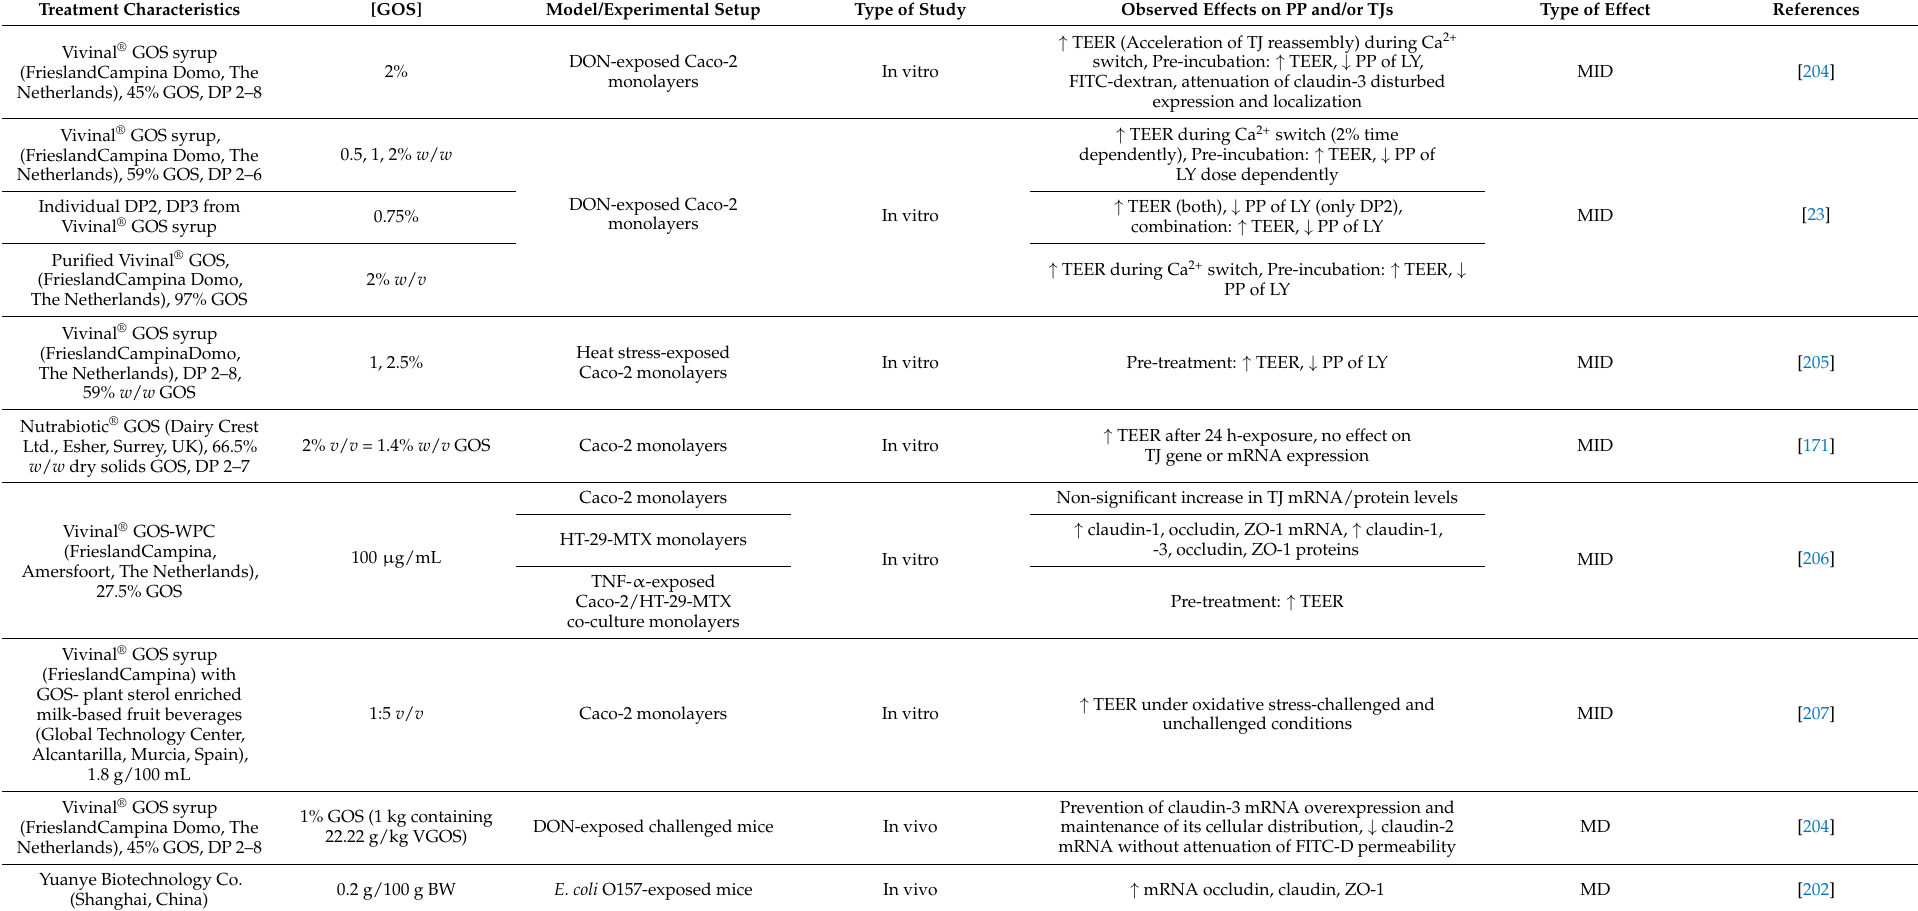
Table 2. Microbiota-dependent and independent effects of GOS on paracellular permeability and/or